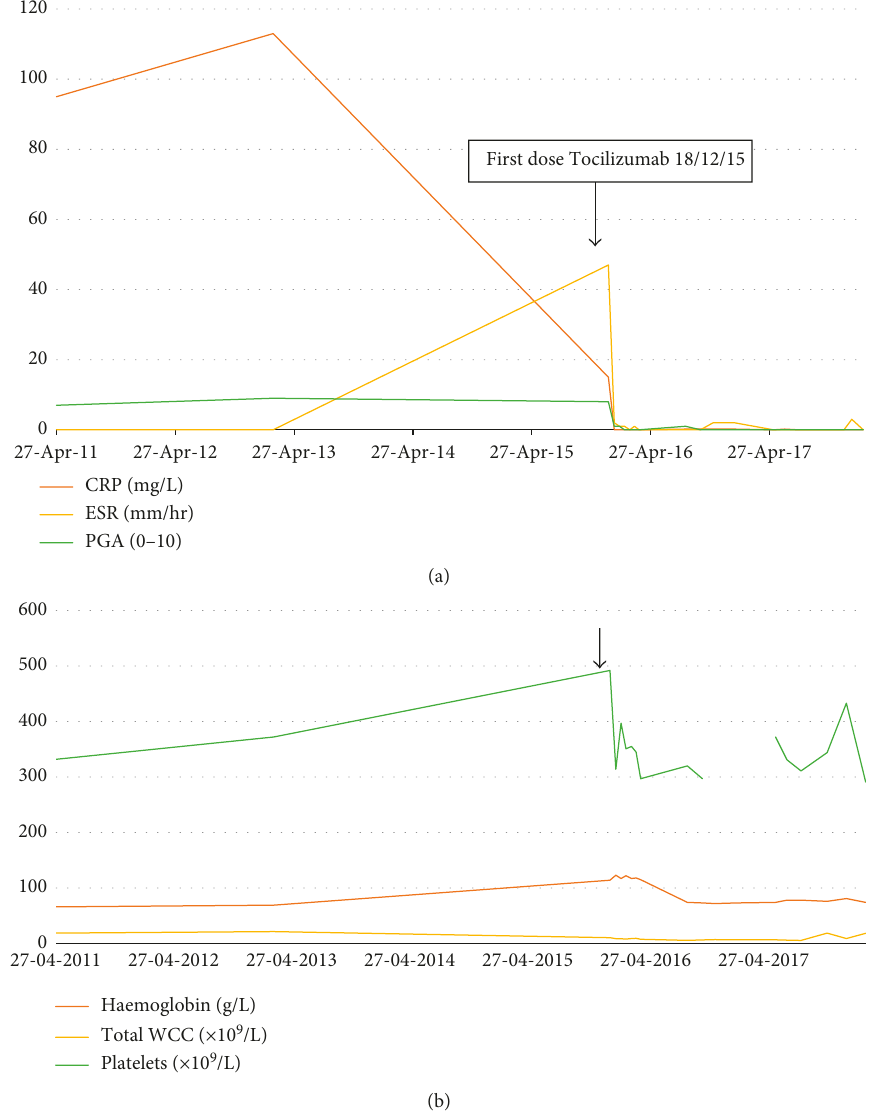
Figure 1: (a) Change in clinical disease activity inflammatory markers in response tocilizumab. Note . PGA: physician global assessment, 0–10, 0 indicating absence of disease activity and 10 indicating severe disease. ESR: erythrocyte sedimentation rate. CRP: C reactive protein. PGA fell from 8/10 immediately before the first tocilizumab infusion to 1/10 when assessed immediately prior to the next infusion 2 weeks later. This excellent clinical and serological response has been sustained for 24 months. (b) Change in haemoglobin, total white cell count, and platelet count in response to tocilizumab. Black arrow shows date of first dose of